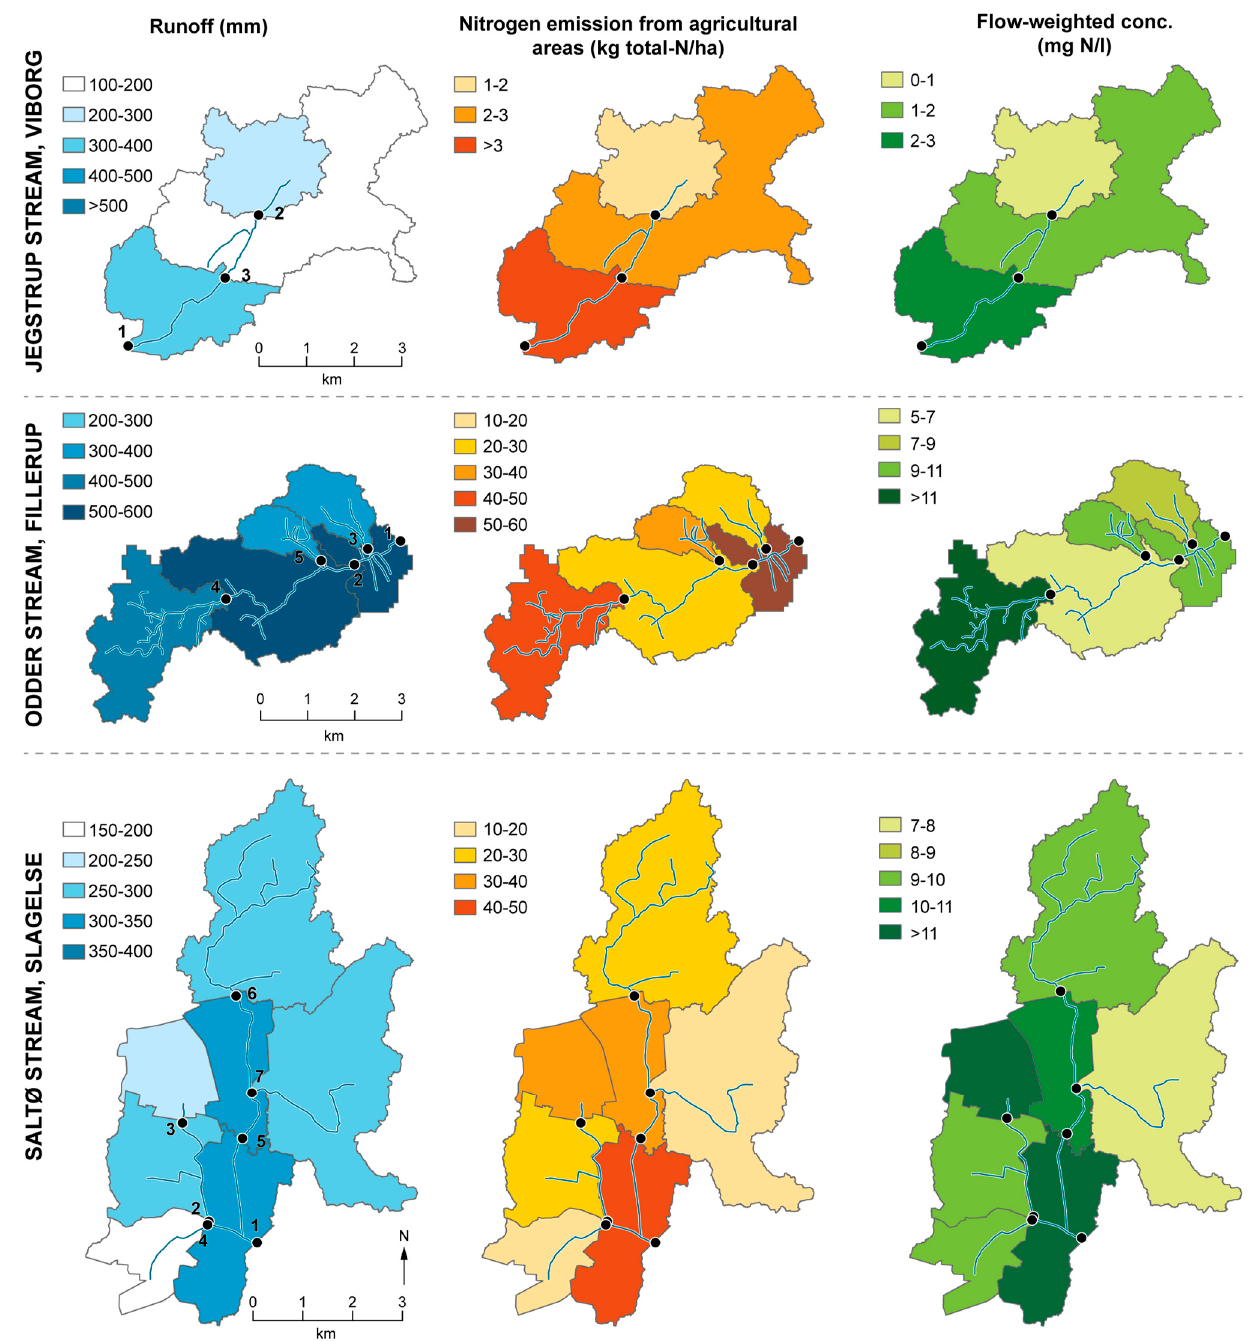
Figure 4. Average calculations of runoff, emission of total N (TN) from agricultural areas to stream edge, estimated by source apportionment and flow-weighted concentration of TN from agricultural areas after bias correction of the TN transport, in the two monitoring years in the sub-catchments of the three main catchments of Jegstrup (3 sub-catchments), Odder (5 sub-catchments), and Saltø (7 sub-catchments). Modified from [28].